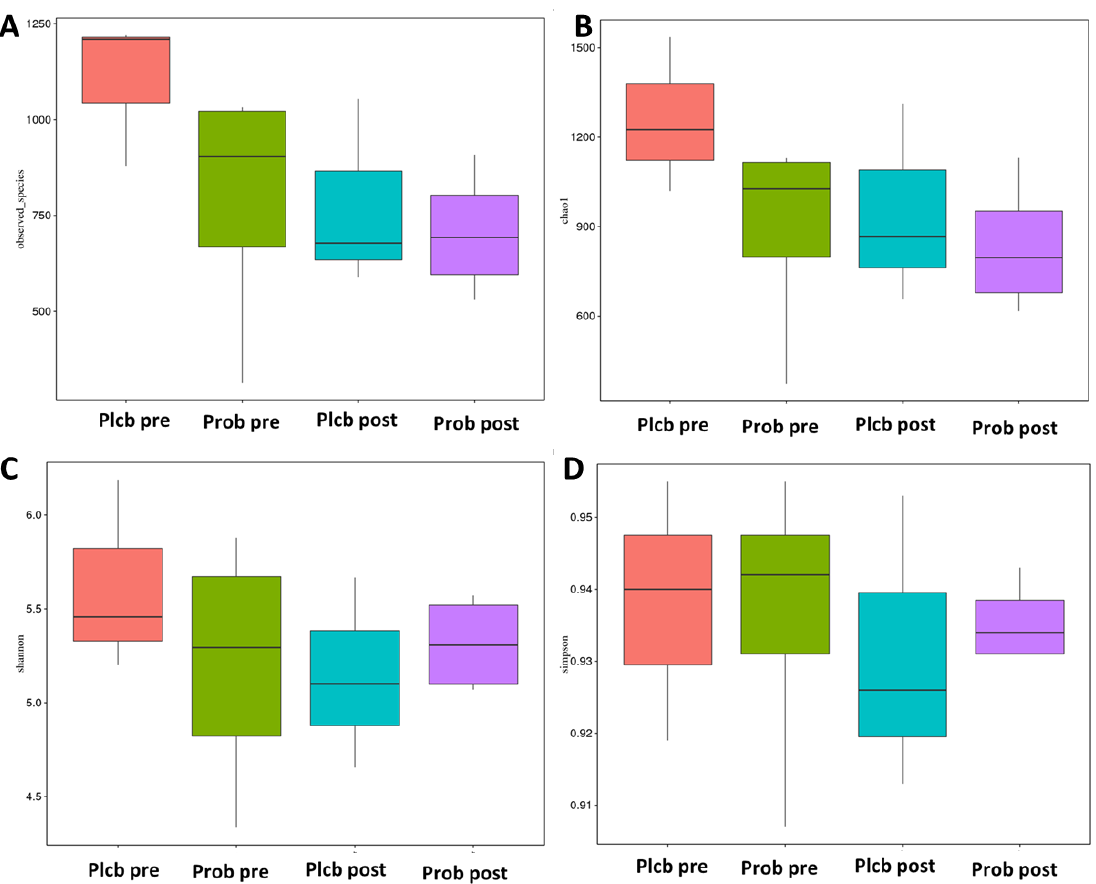
Figure 5. Boxplot alpha diversity index. ( A ) Observed species, ( B ) Chao1, ( C ) Shannon, and ( D ) Simpson.